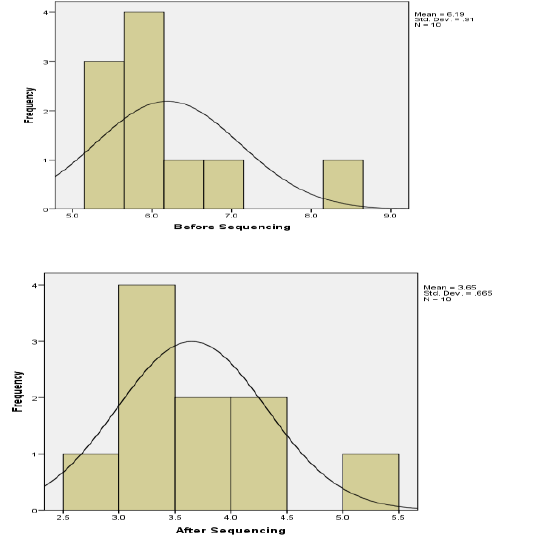
Figure 1: The frequency and mean Visual Analogue Score before & after sequencing